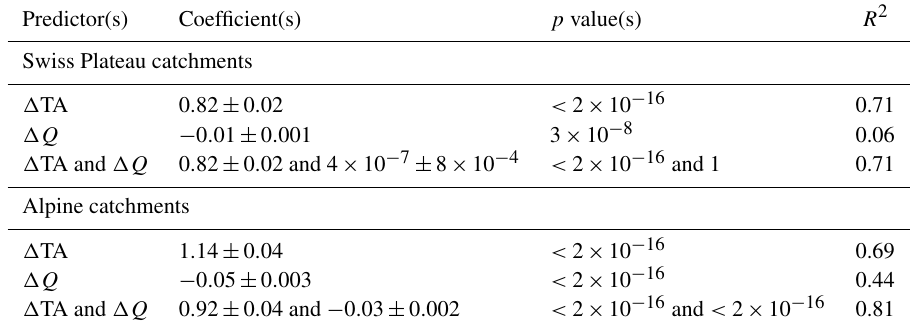
Table 6. Summary of the linear models for changes in river temperature ( (cid:49)T ) using changes in air temperature ( (cid:49) TA), water discharge ( (cid:49)Q ), or both as predictors. Changes in the period 2080–2090 compared to the reference period 1990–2000 are used for RCP8.5. The table shows the coefficients, the p values associated with each predictor, and the adjusted R 2 (discounting the effect of additional explanatory variables) of each model. The linear models are applied separately for the Swiss Plateau catchments (top) and the Alpine catchments (bottom). Predictor(s) Coefficient(s) p value(s) R 2 Swiss Plateau catchments (cid:49) TA 0 . 82 ± 0 .